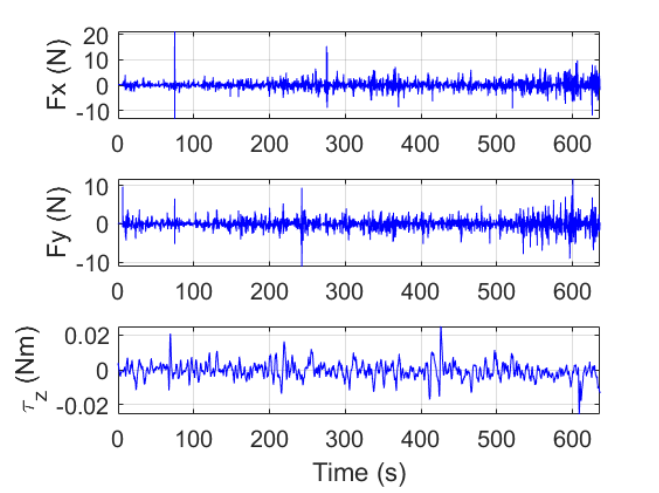
Figure 15. Recorded control commands.